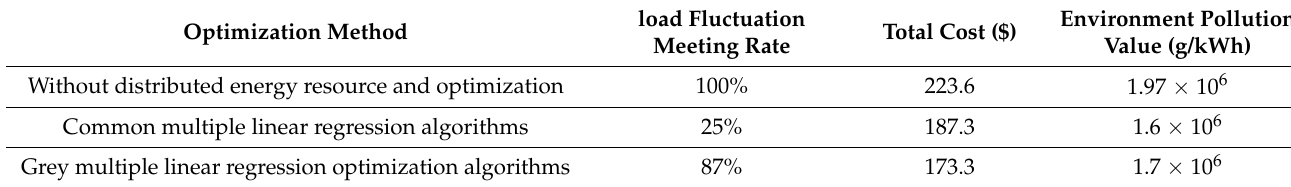
Table 4. A comparison of the performances of different